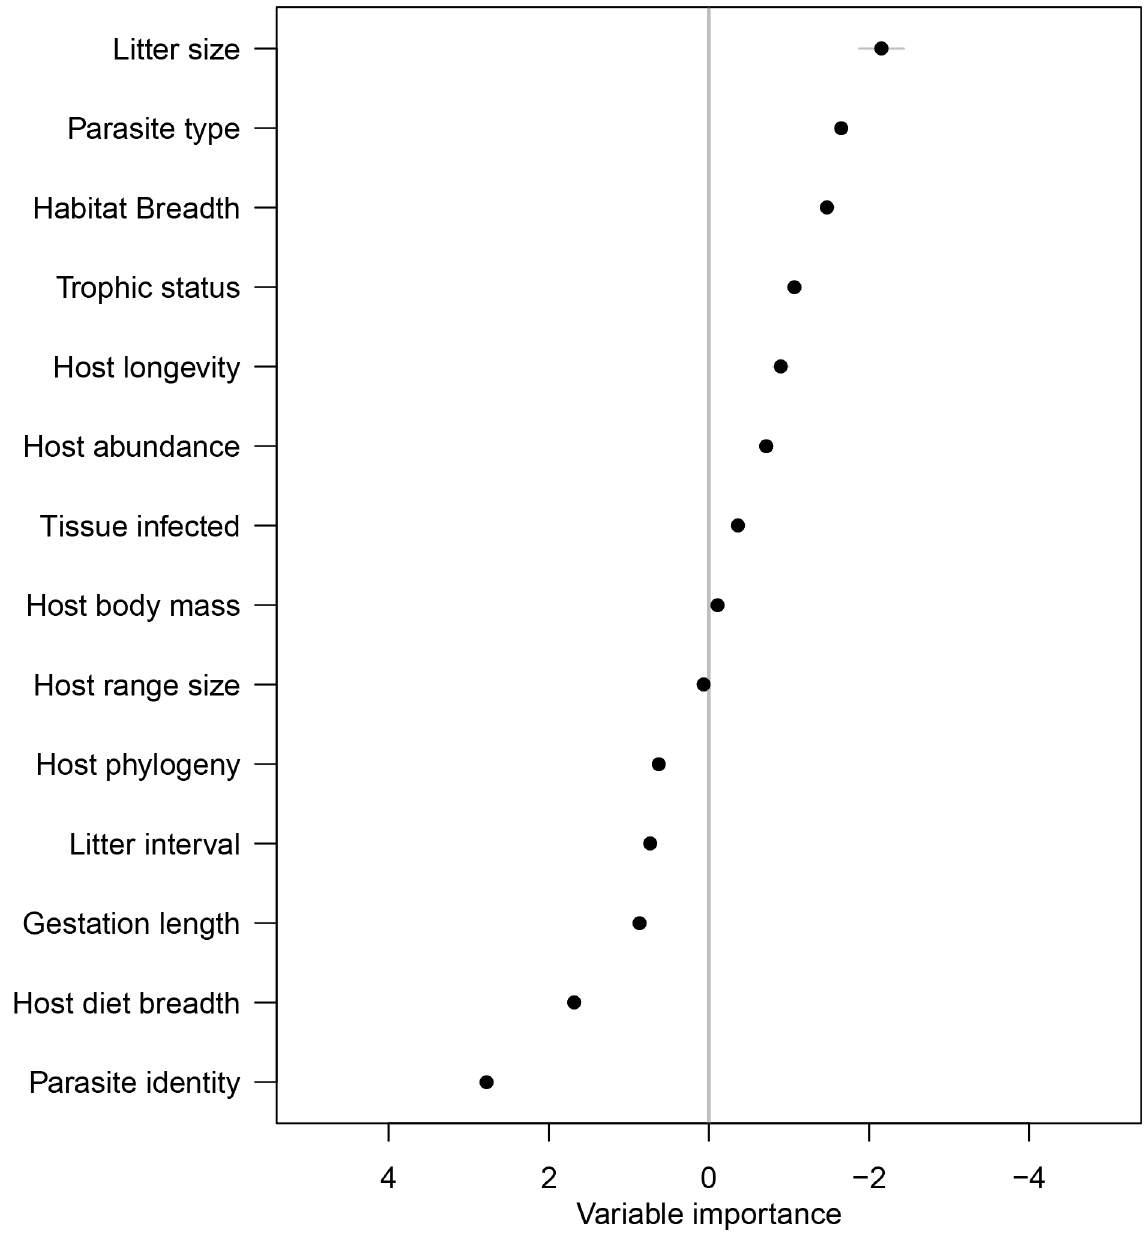
Fig 1. The relative importance of each variable in predicting parasite occurrence in the Sevilleta host-parasite network. Variableimportanceis measuredas the reduction in predictive power by randomizing each variable, and the resultingvariable importance scores are z -scores. Negativescores correspond to the proportional reductionin model performance as a result of variablerandomization. Traits are orderedby importance to the predictivemodel, with the key predictivecovariatesin the upper left (e.g., litter